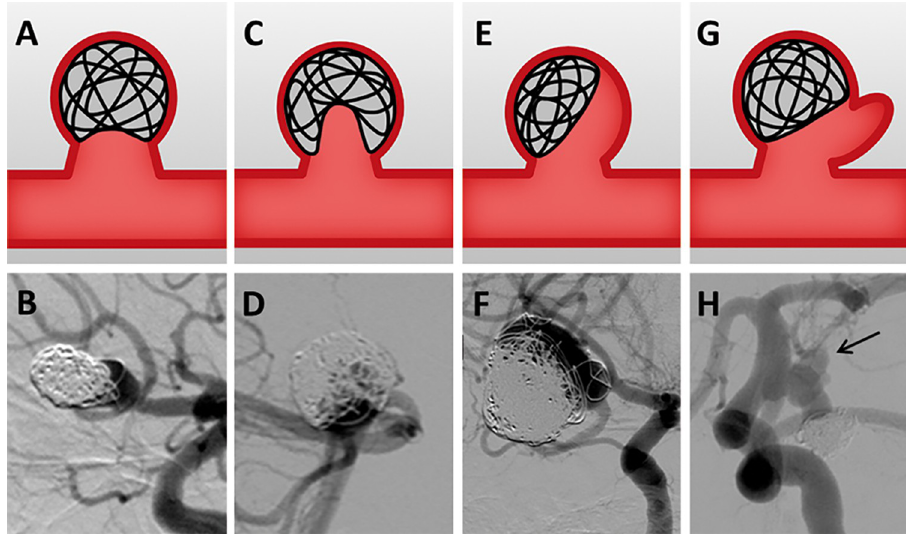
Fig 1. Classification of aneurysm recurrence patterns. (A and E) Type I, enlargement of aneurysm neck. (B and F) Type II, recurrent cavity within the coil mass. (C and G) Type III, recurrent cavity along the aneurysm wall. (D and H) Type IV, formation of a daughter sac. Black arrow indicates a daughter